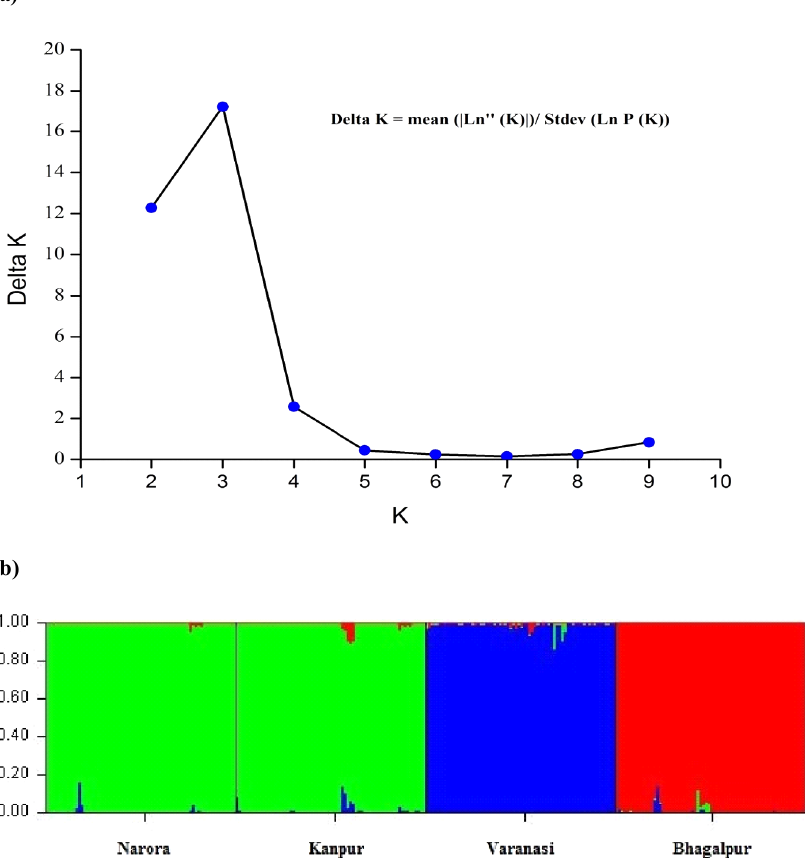
Fig. 2. Estimated population structure of Sperata aor across the river Ganga. (a) Bayesian inference of number of clusters ( K ) among four populations using D K . (b) Plot of assignment probability ( Q -values) of individuals to three genetic groups (resolved within the model of K =3) each represented by a different